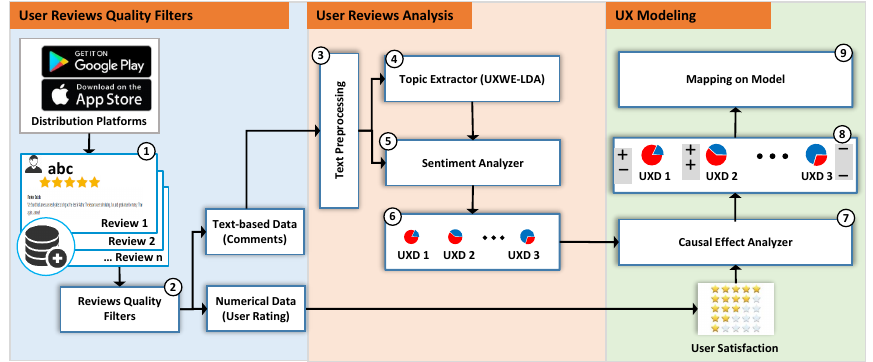
Figure 1. Abstract view of proposed